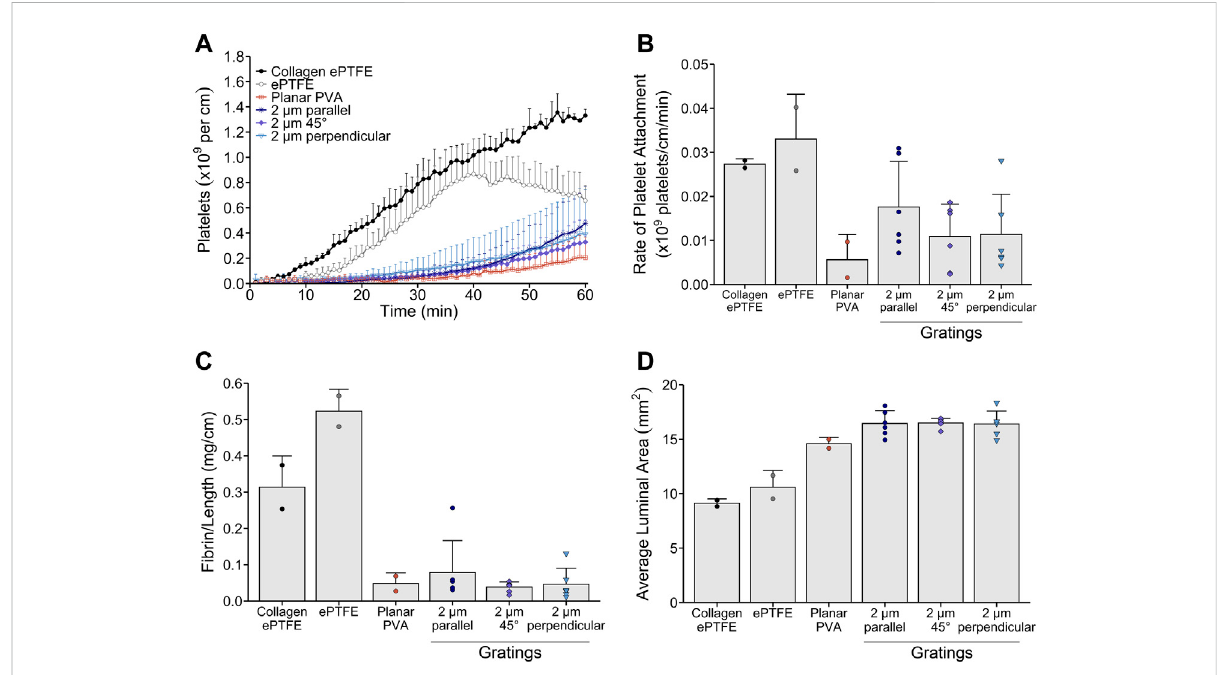
FIGURE 5 Whole blood, ex vivo thrombogenicity testing of micropattern feature orientation relative to physiologic blood fl ow. Tubular 2 µm micropatterned PVA with gratings oriented either parallel, 45 ° , or perpendicular relative to whole blood fl ow ( n = 6) were tested in an ex vivo shunt model to quantify dynamic platelet attachment, rate of platelet attachment, end-point fi brin, and luminal area of the grafts. Collagen-coated ePTFE ( n = 2), ePTFE ( n = 2), and planar PVA (n = 2) were run as animal controls. (A) Platelet accumulation was quanti fi ed over 60 min whole blood exposureandnormalizedtotheaxiallengthforallgrafts.Statisticalanalyseswereperformedonlyonthe2 µmgratingpatternedPVA.Therewereno signi fi cant differences found between the orientations of micropatterned PVA relative to blood fl ow. (B) The rate of platelet attachment was quanti fi ed for the linear range of dynamic platelet accumulation. There were no signi fi cant differences observed for the rate of platelet attachment betweenparallel,45 ° ,orperpendicularorientationofthe2 µmgratings. (C) Fibrindatawerequanti fi edandnormalizedtotheaxiallengthforallgrafts. No signi fi cant differences were observed among orientations of the 2 µm gratings relative to blood fl ow. (D) The average luminal area of the